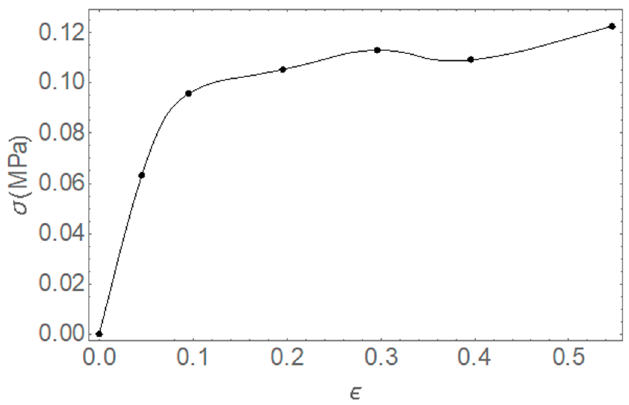
Figure 4. Typical stress-strain curve for uniaxial test on AFA-100.